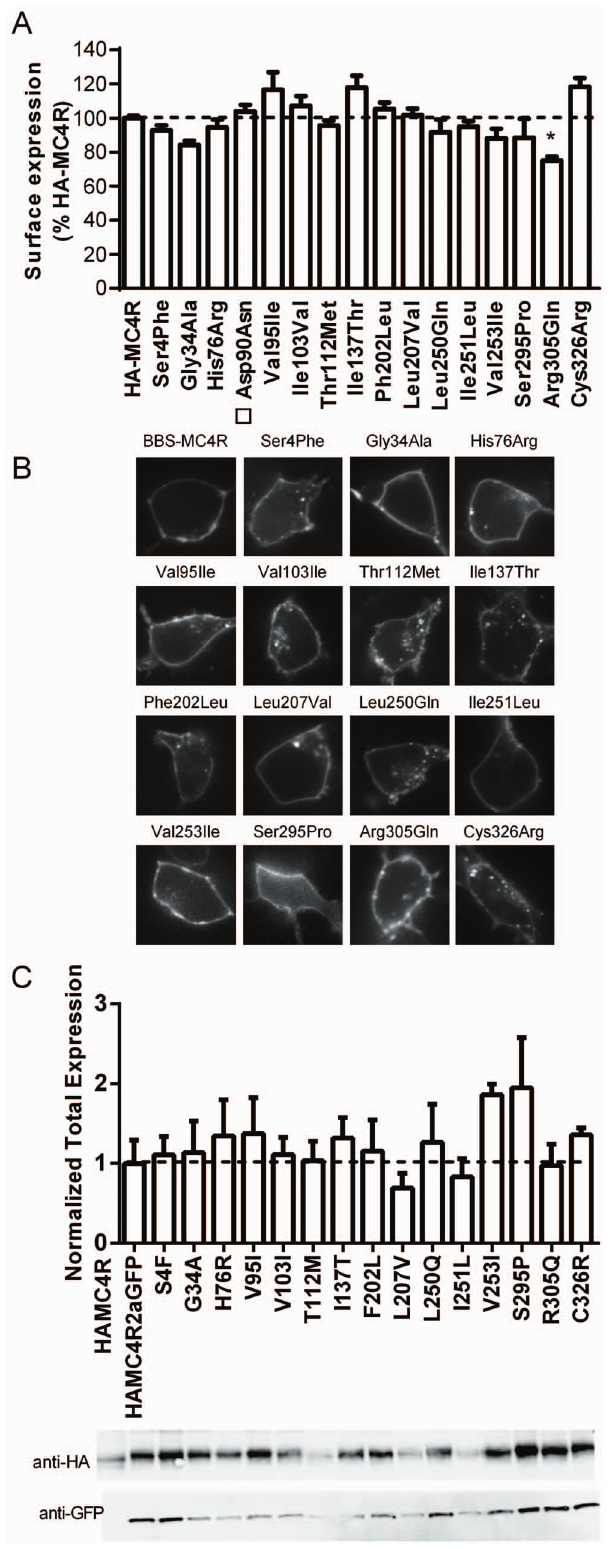
Figure 3. Expression of MC4R mutants. A) ELISA of HEK293 cells expressing wild-type MC4R or mutations. The cell surface expression was normalized to total expression for each mutant and then to wild- type receptor for that batch (* denotes p , 0.05 compared to wild-type by a one way ANOVA with Dunnet’s post-hoc test). % MC4R mutant